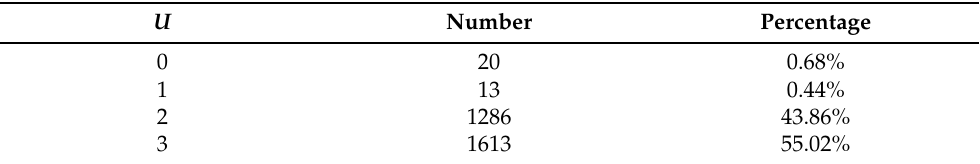
Table 3. The U -distribution of asteroids in DAMIT.